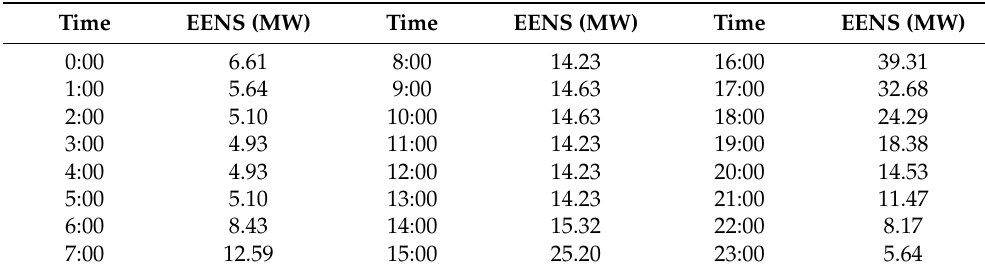
Table 6. Expected loss of